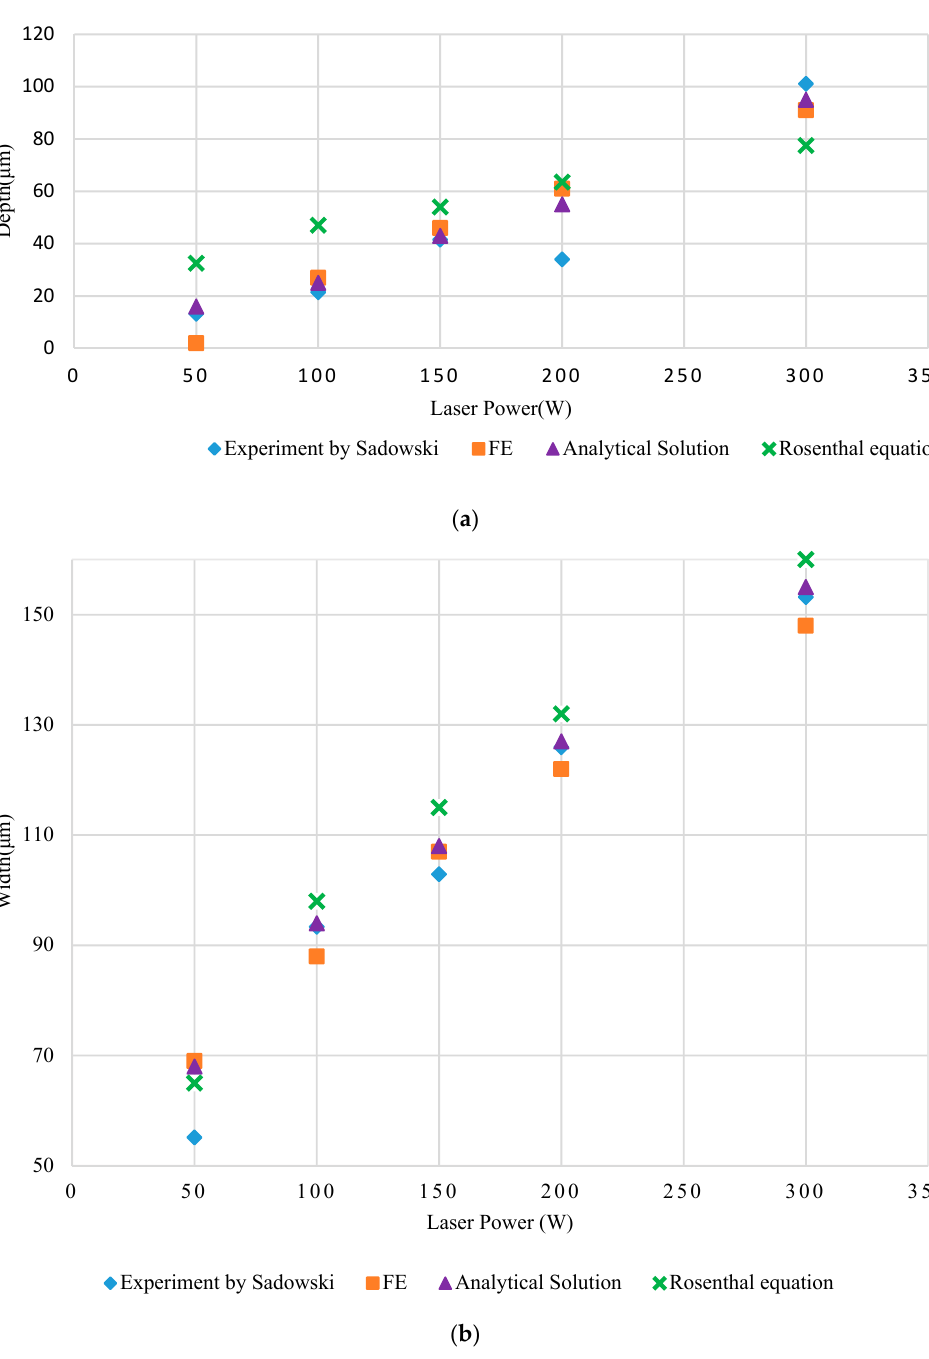
Figure 4. The dimension of melt pool of In718 by selective laser melting (SLM) processing at di ff erent laser power from the experiment by Sadowski [12], the finite element (FE) modeling and the analytical solution (equation from this paper and the Rosenthal equation). ( a ) Depth of melt pool, ( b ) width of melt